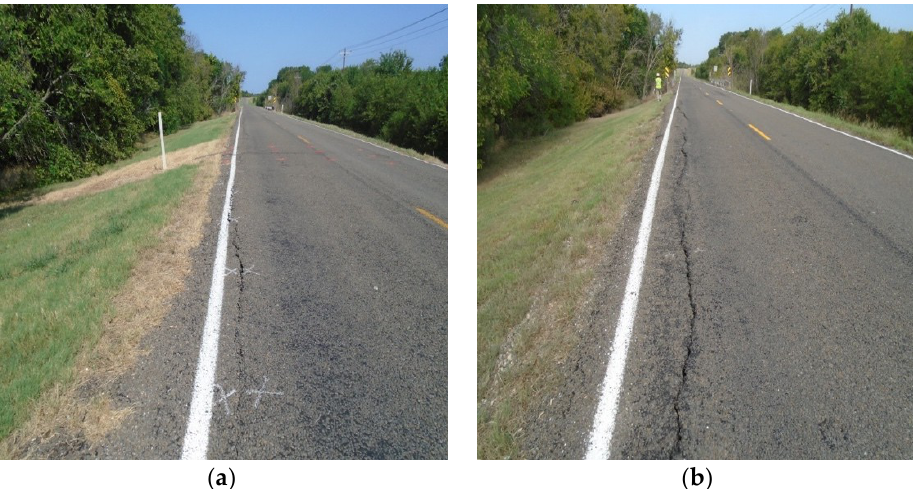
Figure 8. Crack after ( a ) Summer 2014 and ( b ) Summer 2015 at FM 2757 site.